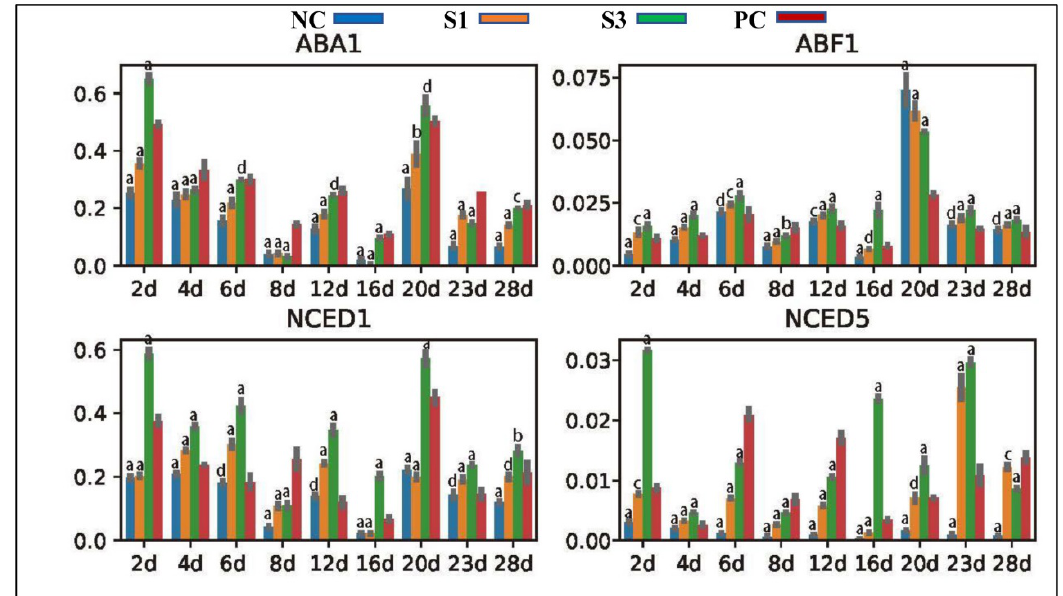
Figure 7. Expression profiles of genes participating in ABA production and signal transduction in differently treated samples. a, p -value < 0.001; b, p -value < 0.01; c, p -value < 0.05; d, p -value > 0.05.